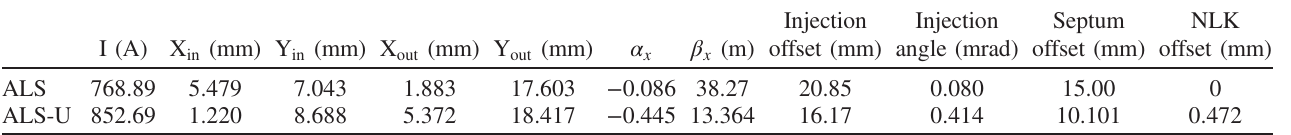
TABLE I. Parameters of optimized NLK injections for both ALS and ALS-U.